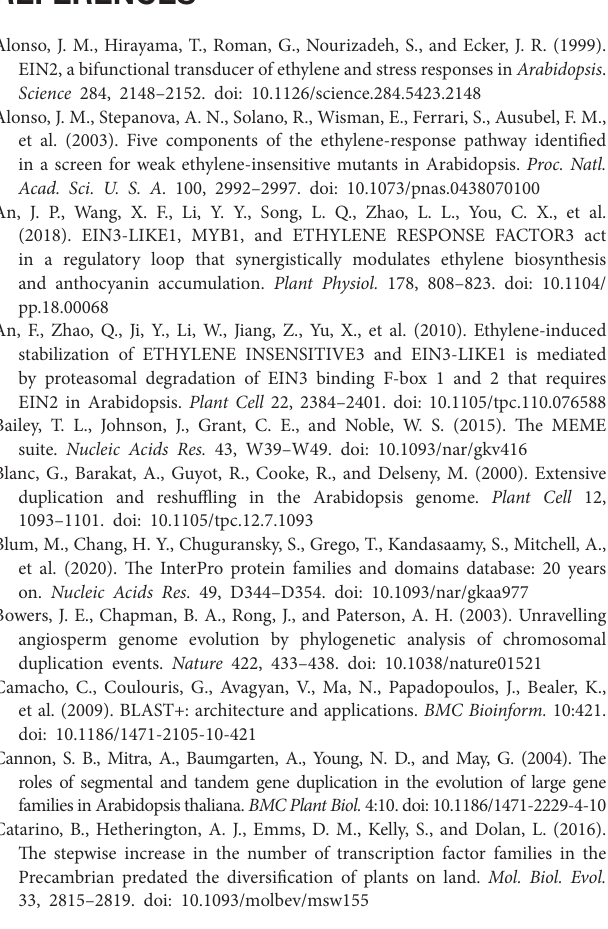
Supplementary Figure S9 | Sequence alignment of B2 subgroup EIL proteins. Supplementary Figure S10 | Sequence alignment of B3 subgroup EIL proteins. Supplementary Figure S11 | Sequence alignment of C1 subgroup EIL proteins. Supplementary Figure S12 | Sequence alignment of C2 subgroup EIL